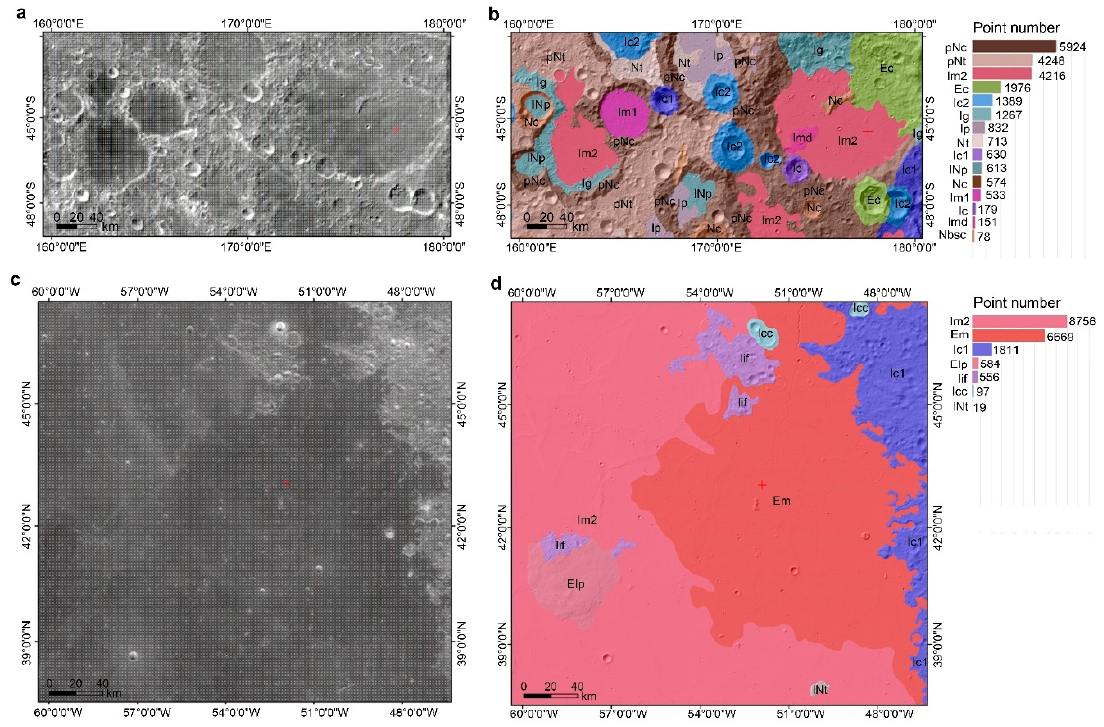
Figure 2. Image and geological unit distribution of the two study areas. ( a , b ) Chang’e-4 landing area. ( c , d ) Chang’e-5 landing area.